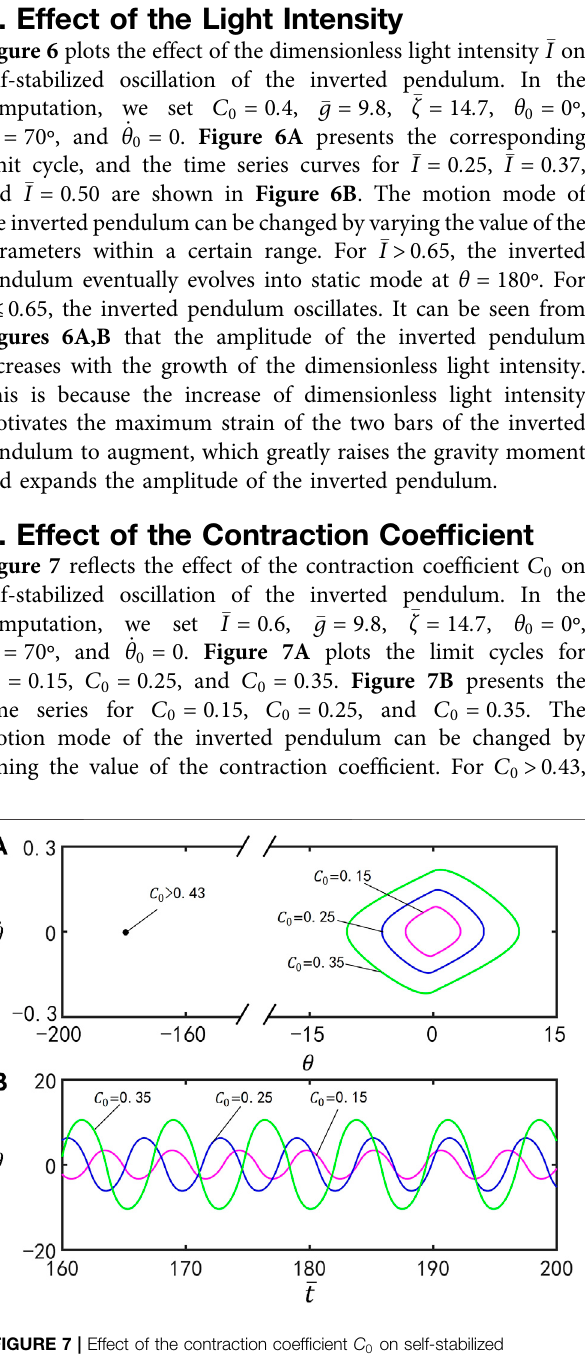
(cid:2) 0 . 15, C (cid:2) 0 . 25,and C (cid:2) 0 . 35. 0 0 0